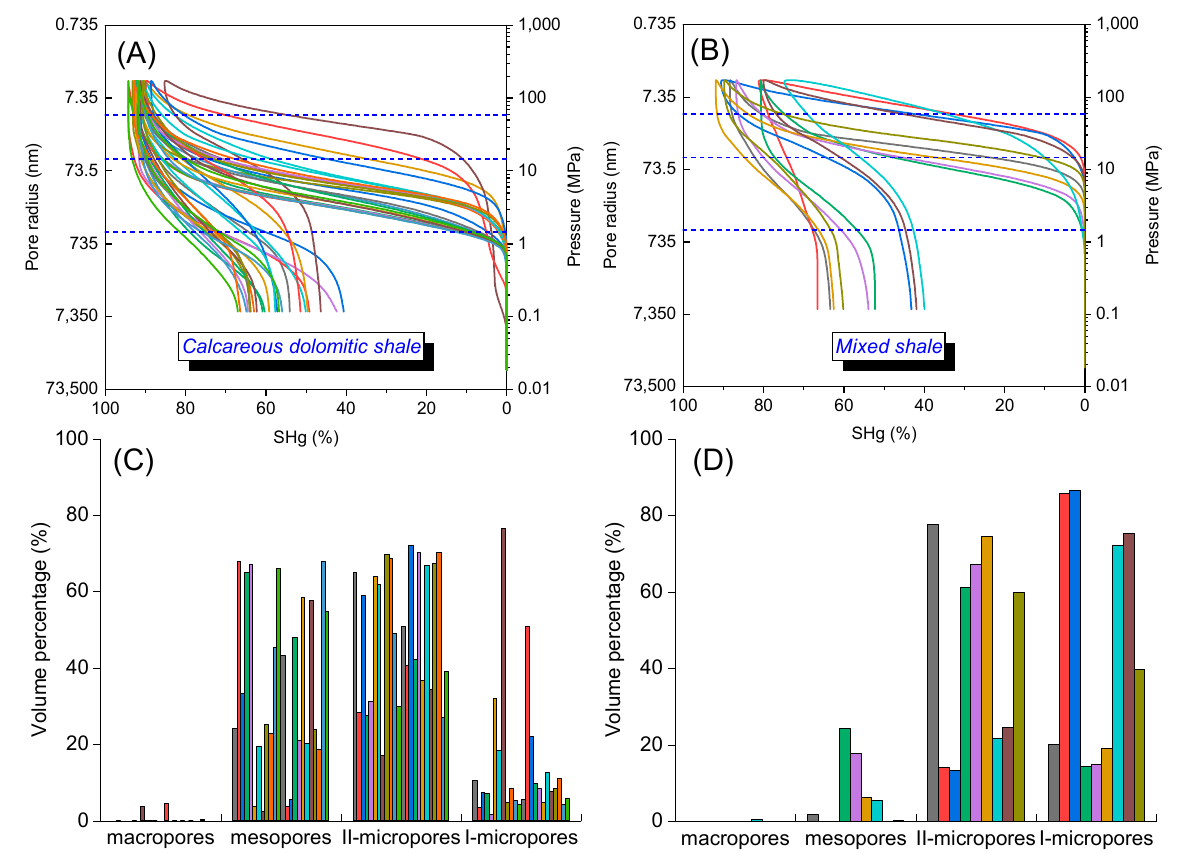
Figure 6. Mercury intrusion/extrusion curves of calcareous dolomitic shales ( A ) and mixed shales ( B ). Volume percentage of pores with different sizes in calcareous dolomitic shales ( C ) and mixed shales ( D ), macropores ( ˃ 1000 nm), mesopores (100–1000 nm), II-micropores (25–100 nm), and I-micropores ( ˂ 25 nm).